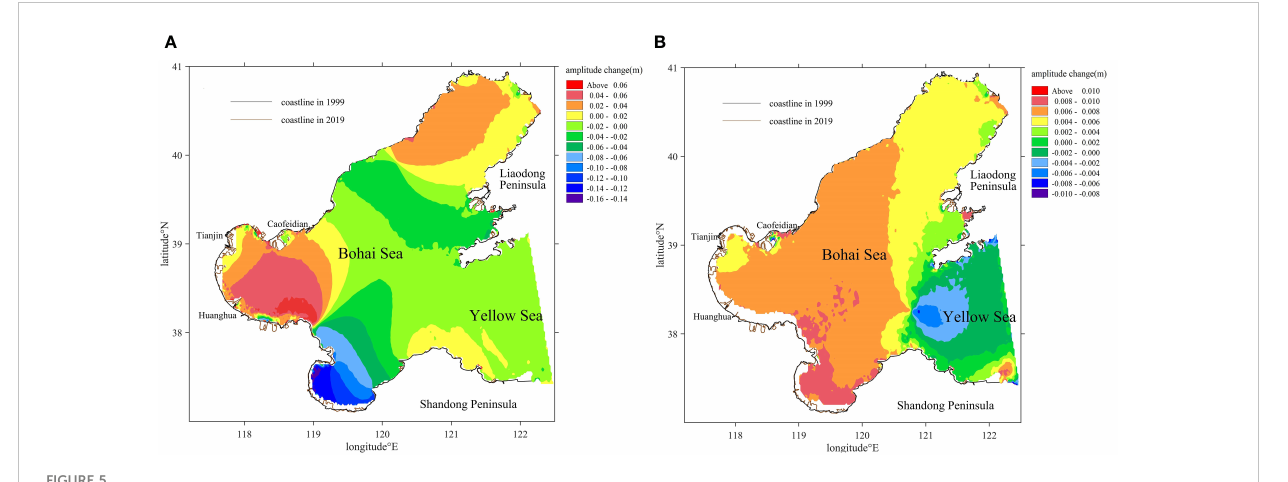
FIGURE 5 Tidal amplitude changes from 1999 to 2019 of (A) M2, (B) K1.